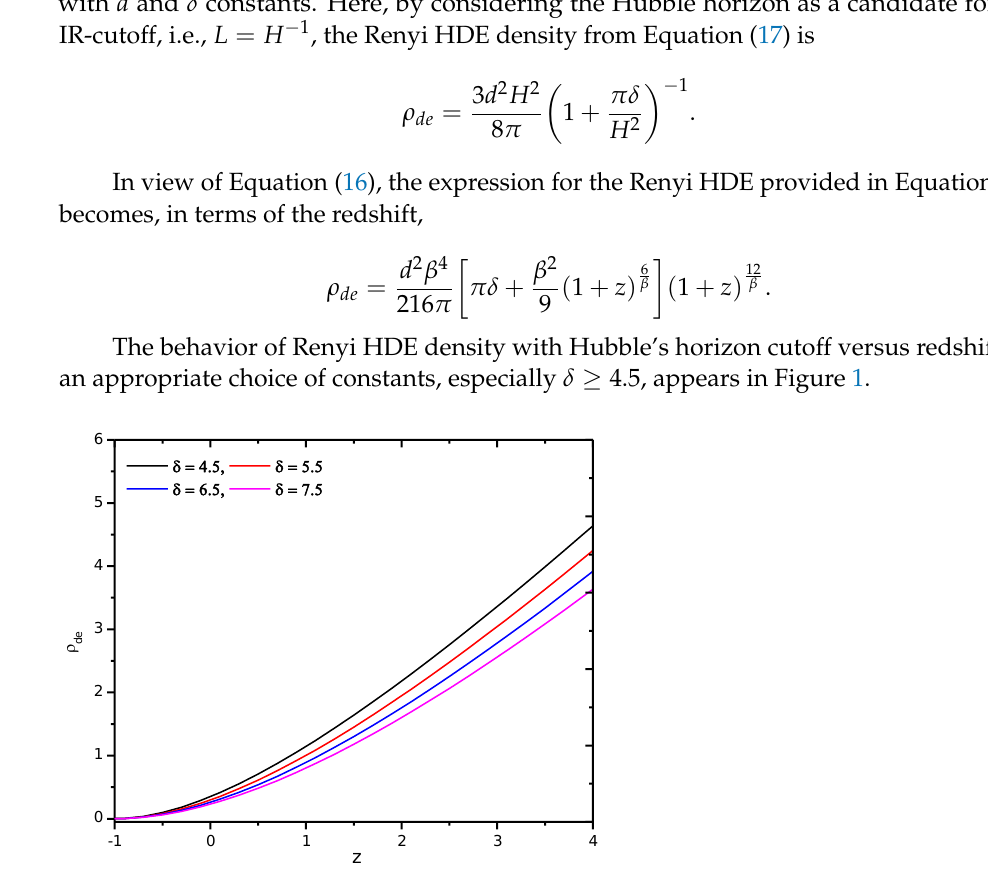
Figure 1. Behavior of Renyi holographic dark energy density with Hubble’s horizon cutoff versus redshift for the appropriate choice of constants d = 1.82 and β =